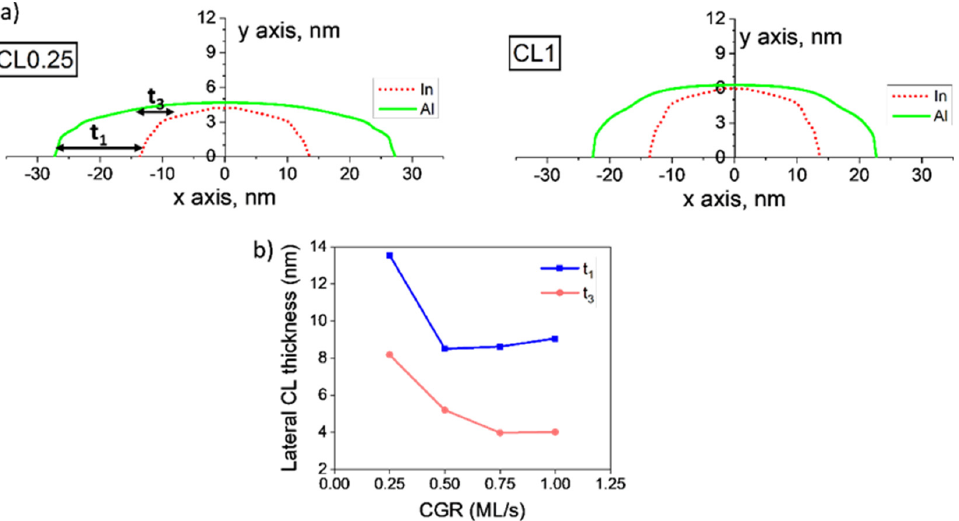
Figure 8. ( a ) Average contours of the QD and CL for layers CL0.25 and CL1. Lateral thicknesses of the CL at the base and close to the apex are named t 1 and t 3, respectively. ( b ) Lateral thicknesses t1 and t3 of the CL versus the